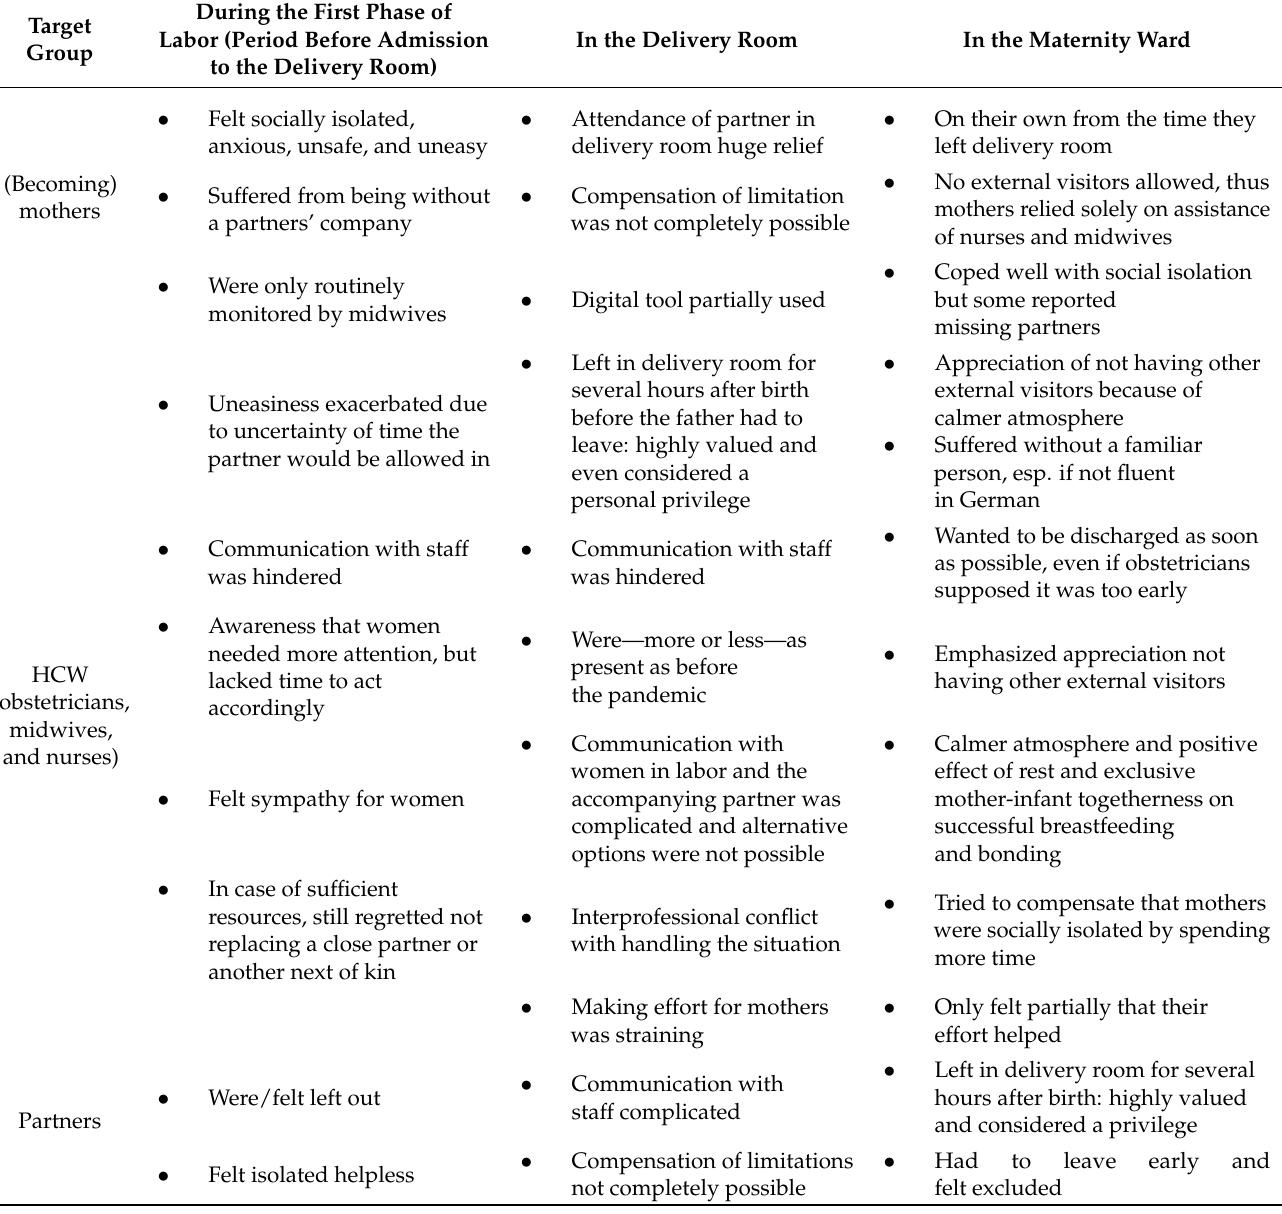
Table 5. Aggregated findings: Impact of COVID-19 pandemic on varying target groups in different phases of